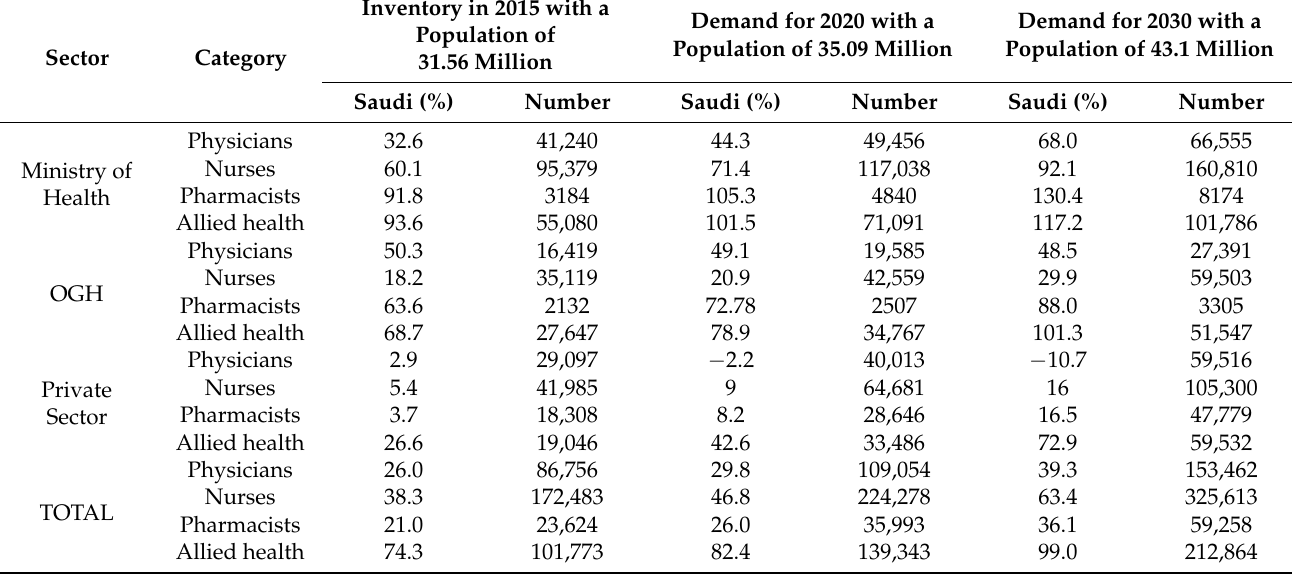
Table 1. Healthcare professionals total inventory in 2015 and total demand for 2020 and 2030.